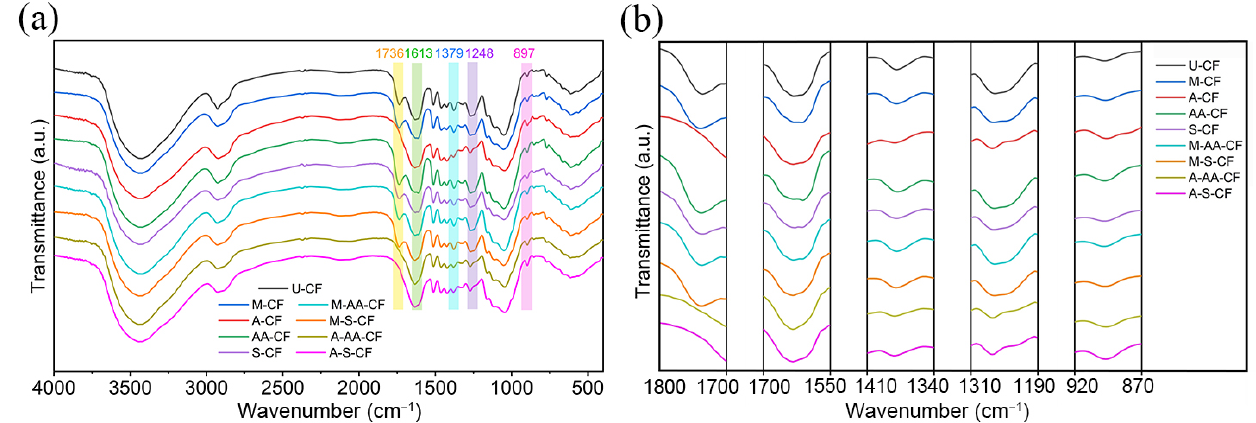
Figure 5. ( a ) FTIR spectra of coir fibers, ( b ) Enlarged view of labeled regions in FTIR spectra.